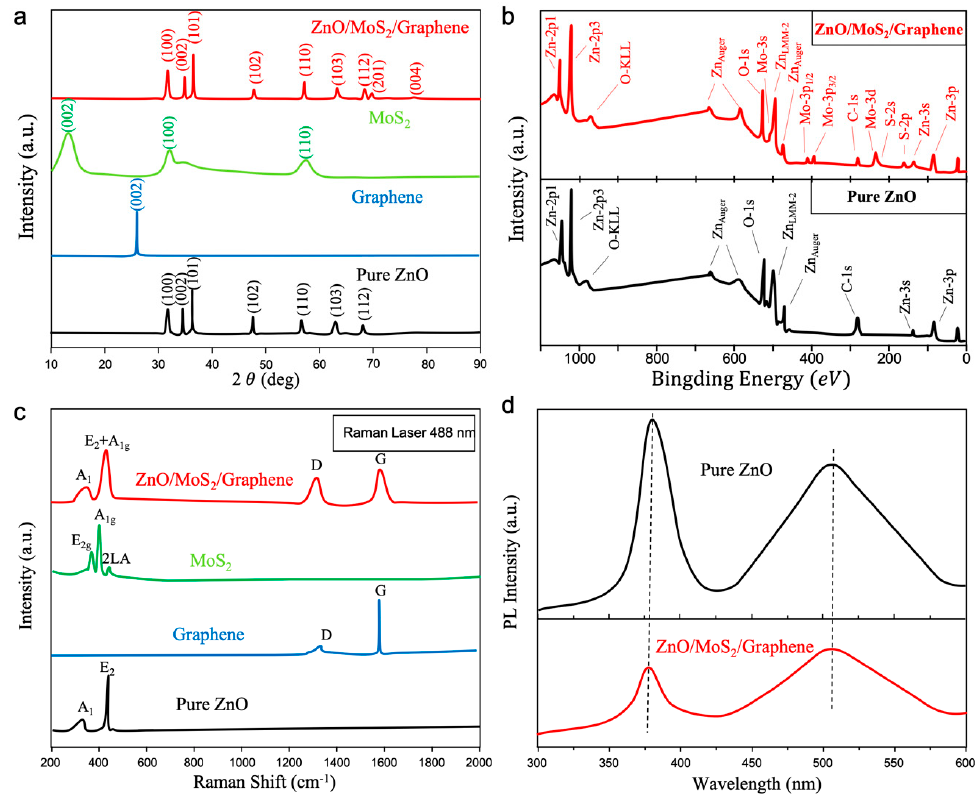
Figure 3. Structural characterization of the various samples. ( a ) XRD measurements of each component; ( b ) X-ray photoelectron spectrometer (XPS) data of pure ZnO and ZnO / MoS 2 / graphene heterostructures; ( c ) Raman characterizations of each component; ( d ) photoluminescence (PL) spectra of the ZnO and ZnO / MoS 2 / graphene